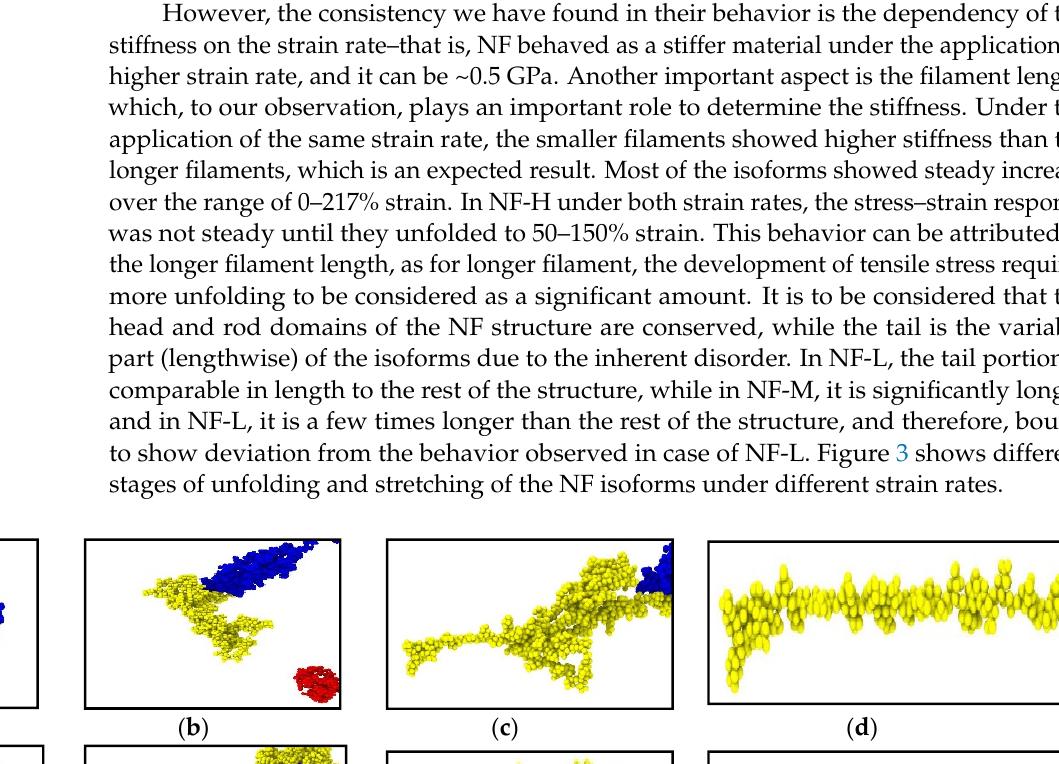
Figure 3. Snapshots at different timesteps during the tensile test performed on NFL and NFH (strain rate: 1 × 10 9 s − 1 ). ( a ) Initial structure of NFL; ( b ) NFL tail region: 0% strain; ( c ) NFL tail region: 180% strain, showing simultaneous unfolding and stretching; ( d ) NFL tail region: 360% strain, showing pure stretching at significant portion of tail region; ( e ) Initial structure of NFH; ( f ) NFH tail region: 0% strain; ( g ) NFH tail region: 160% strain, showing simultaneous unfolding and stretching; ( h ) NFH tail region: 320% strain, showing pure stretching at significant portion of tail region. Color legend: Red: head domain, blue: rod domain, yellow: tail